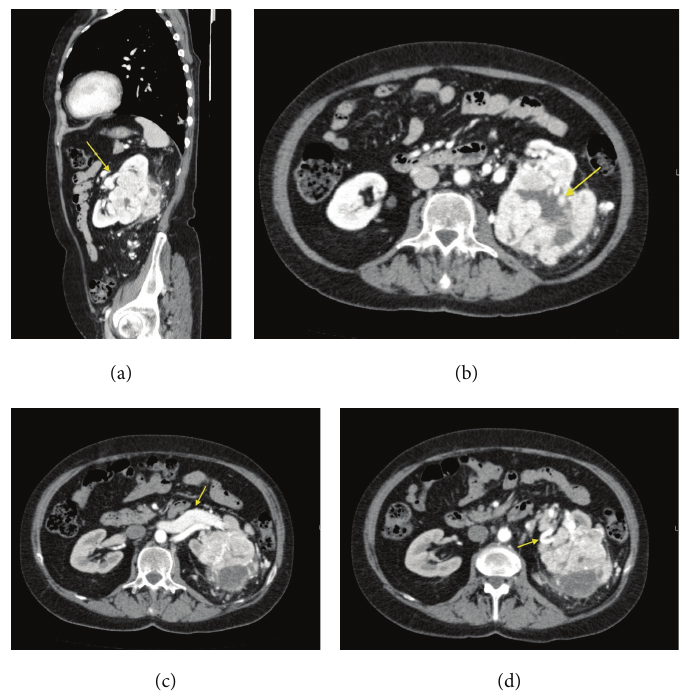
Figure 2: Images show the contrastographic behavior of the renal lesion and its relations with the surrounding anatomical structures. The lesion showed an inhomogeneous enhancement after contrast medium administration due to the presence of solid parts (a), and many colliquative-necrotic areas and intralesional calcifications (b) were also seen. An enlargement of the ipsilateral splenic vein, 9 mm sized, (c) and many intralesional collateral vessels (d) were seen. (a) CECT-MPR-Sagittal Plane. (b) CECT-Arterial Phase-Axial. (c) CECT-Venous phase-Axial. (d) CECT-Arterial